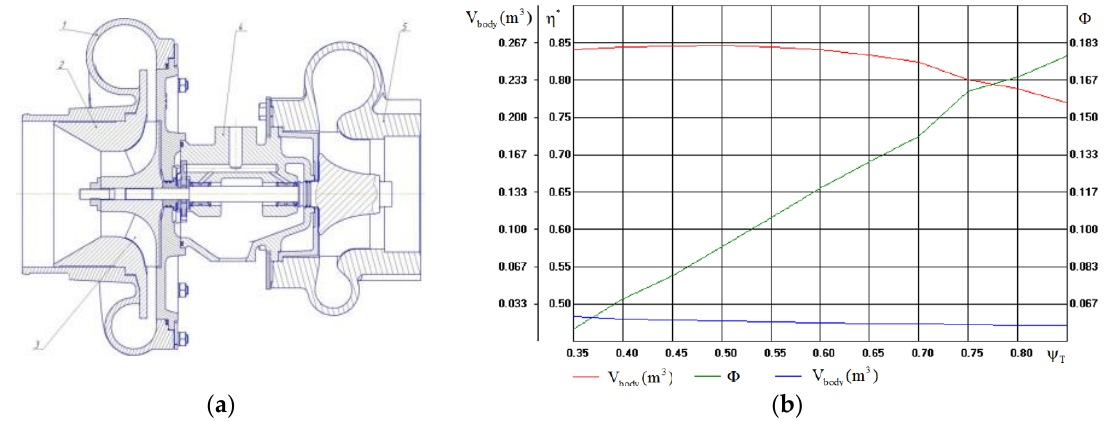
Figure 13. (a) Section of a turbocharger unit with a centrifugal compressor and a radial turbine, and ( b ) compressor candidates’ parameters with different loading factors ψ T des =